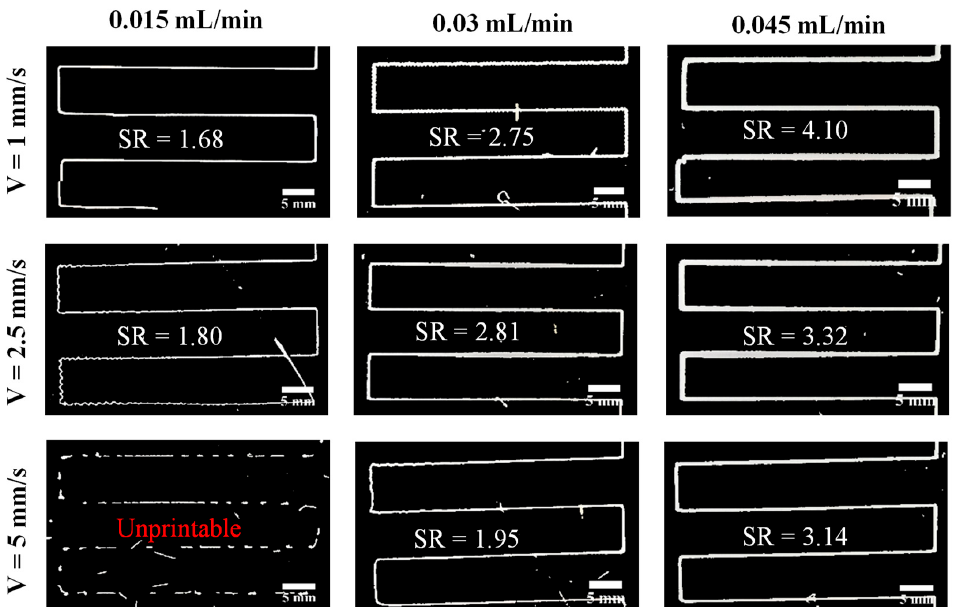
Figure 5. The optimization of the printing speed and flow rate for the Alg_MCC 40 ink. The spreading ratio of the printed shape was calculated using the ImageJ 1.52a software (Wayne Rasband, National Institutes of Health, Bethesda, MD, USA).